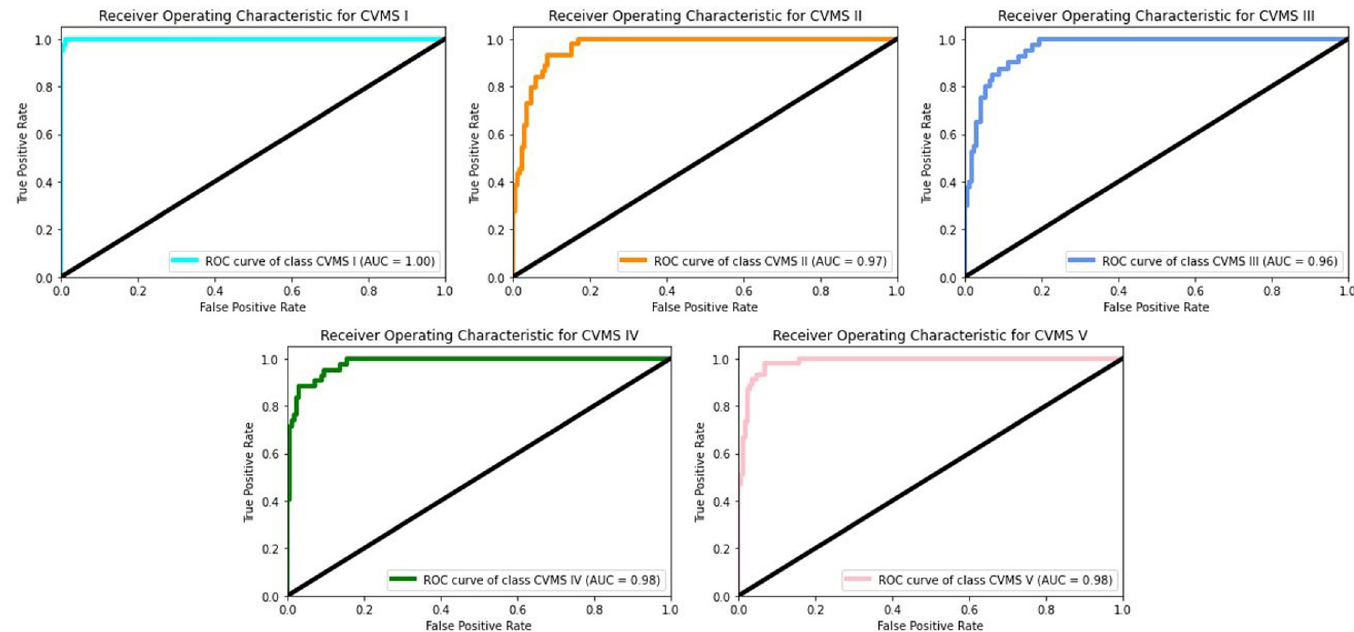
Fig 8. ROC curves and the corresponding AUC values. The curves are plotted TPR vs FPR one selected class against the remaining classes.